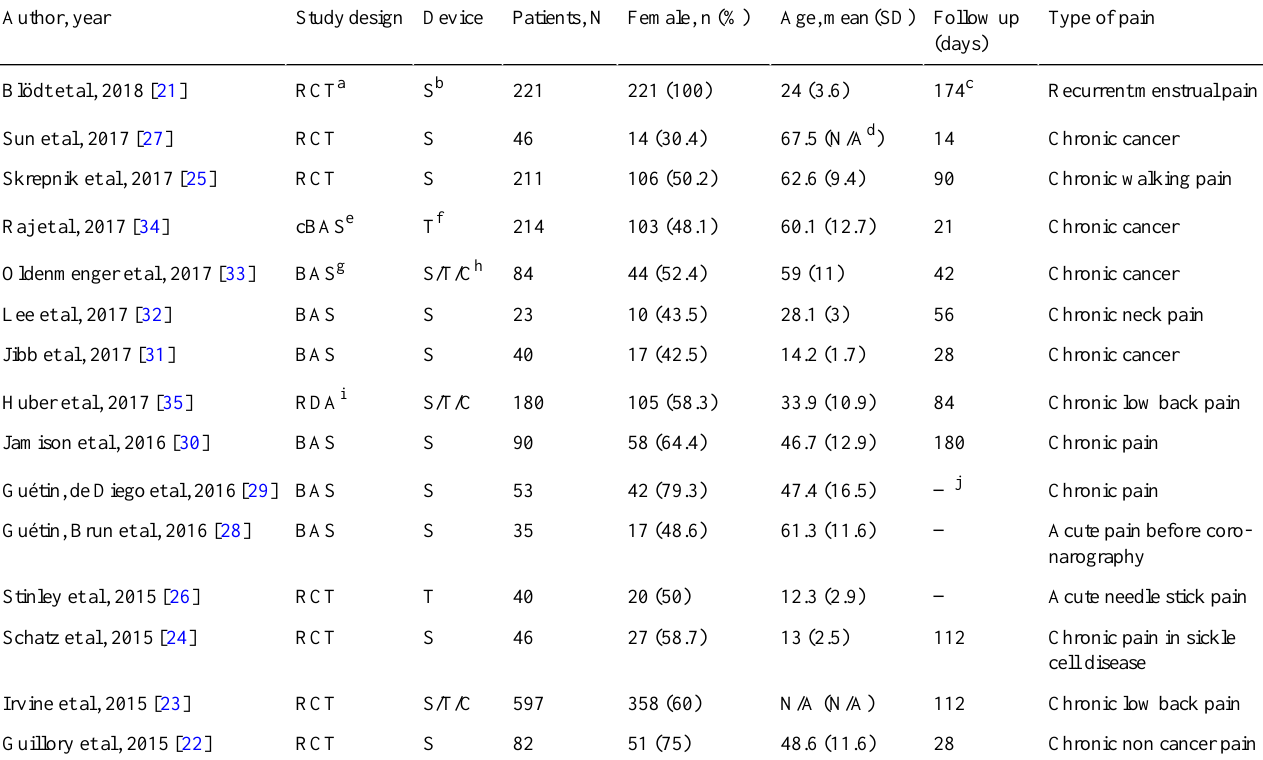
Table 1. Baseline characteristics of all included